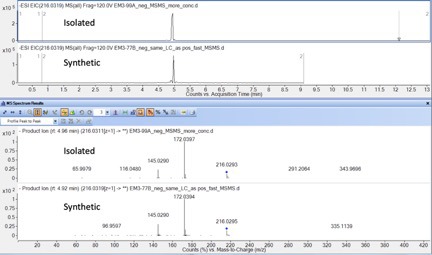
Comparison of negative mode fragmentation pattern of ACNQ isolated from MR-1 spent supernatant (top) and synthesized material (bottom).All fragmentation matched and both metabolites eluted at the same time thus confirming the structure of the natural product.